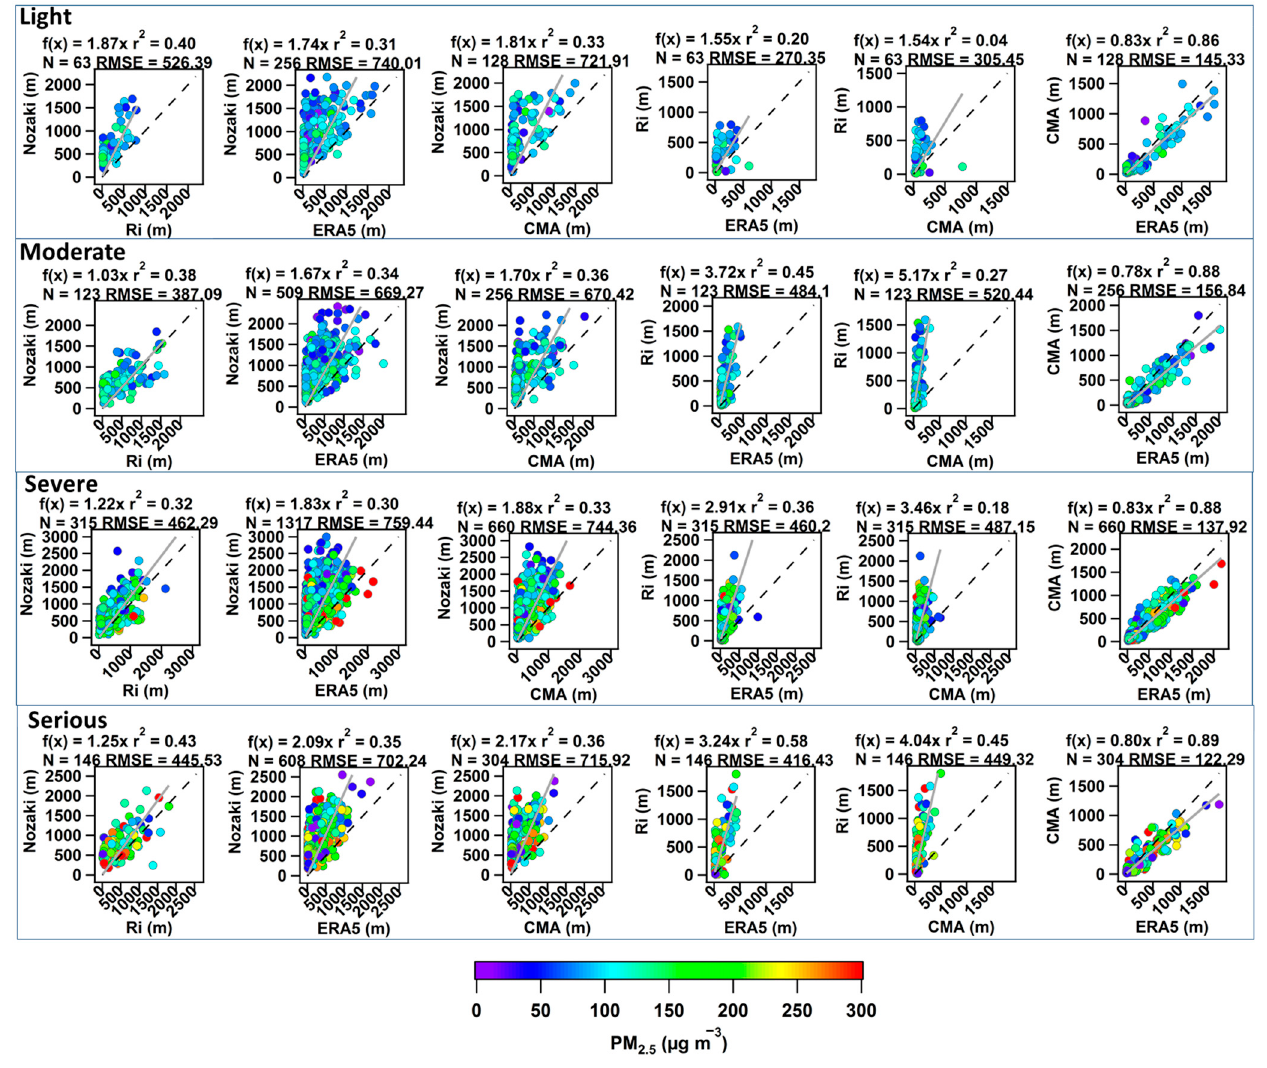
Figure 4. BLH scatter diagram of four BLH methods under different pollution processes. Figure 4. BLH sca tt er diagram of four BLH methods under di ff erent pollution processes. ( 𝑟 (cid:2870) : corre- lation coe ffi cient; N: number of samples; RMSE : Root-mean-square Error; Color indicates the mass ( r 2 : correlation coefficient; N: number of samples; RMSE: Root-mean-square Error; Color indicates concentration of PM 2.5 ). the mass concentration of PM 2.5